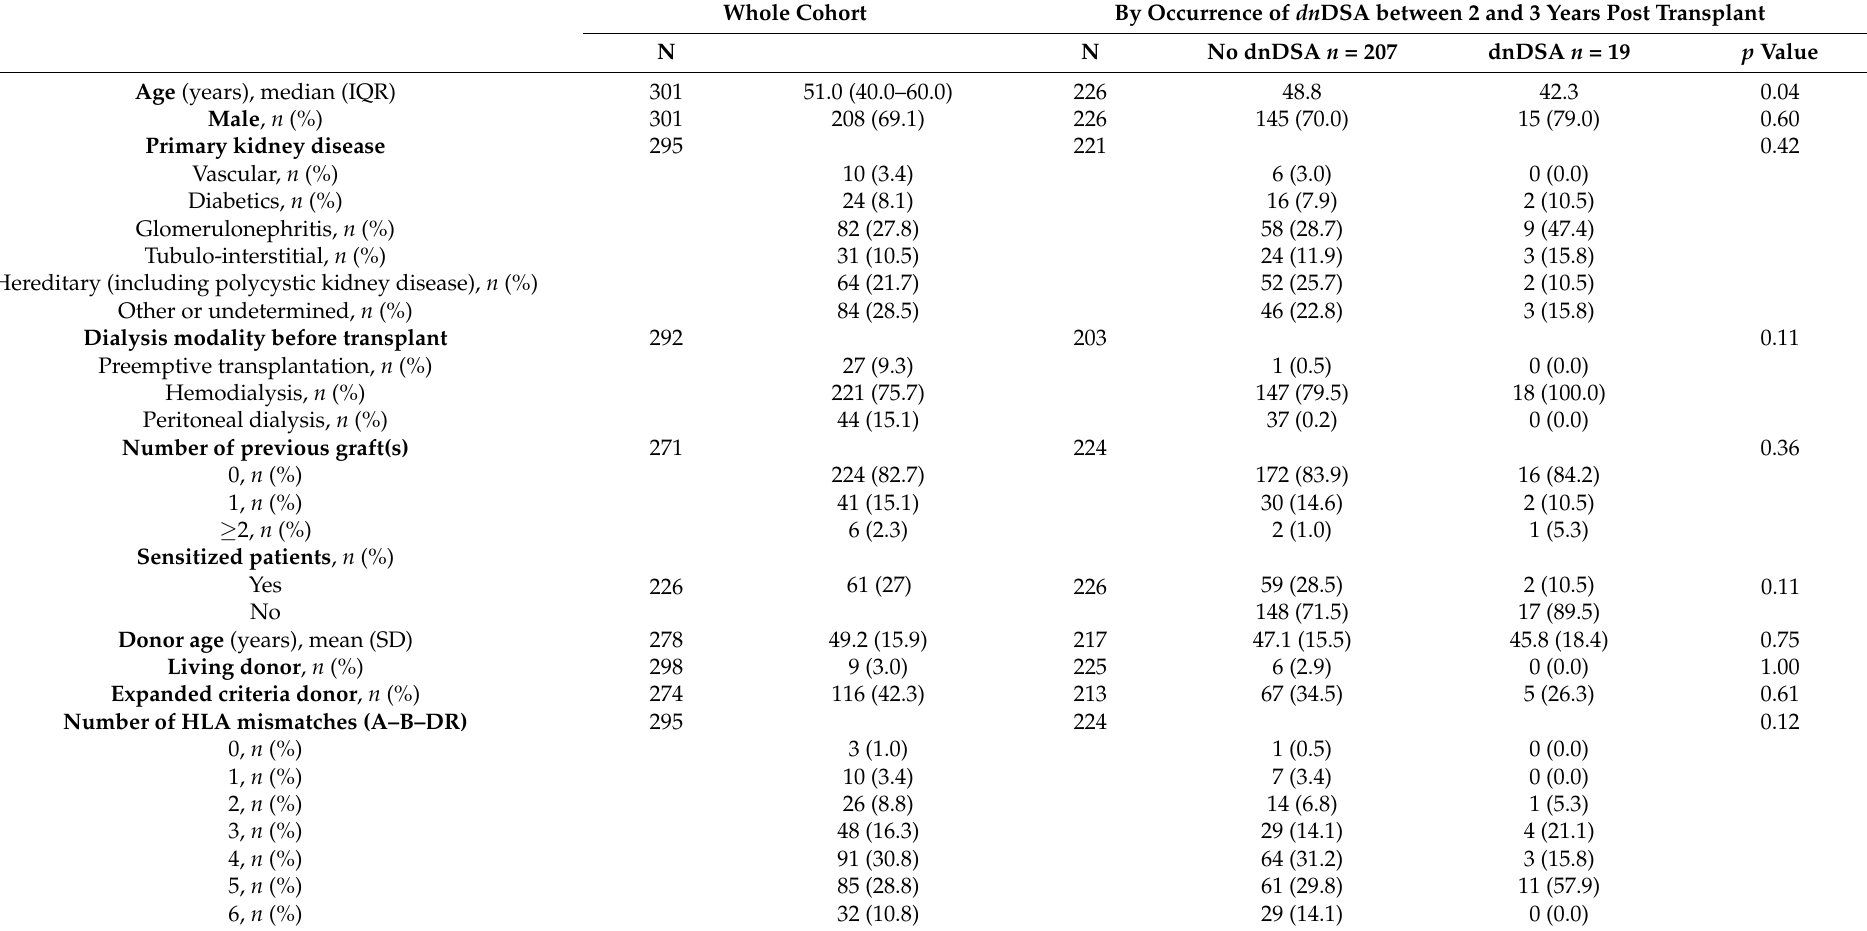
Table 1. Patients’ characteristics at time of